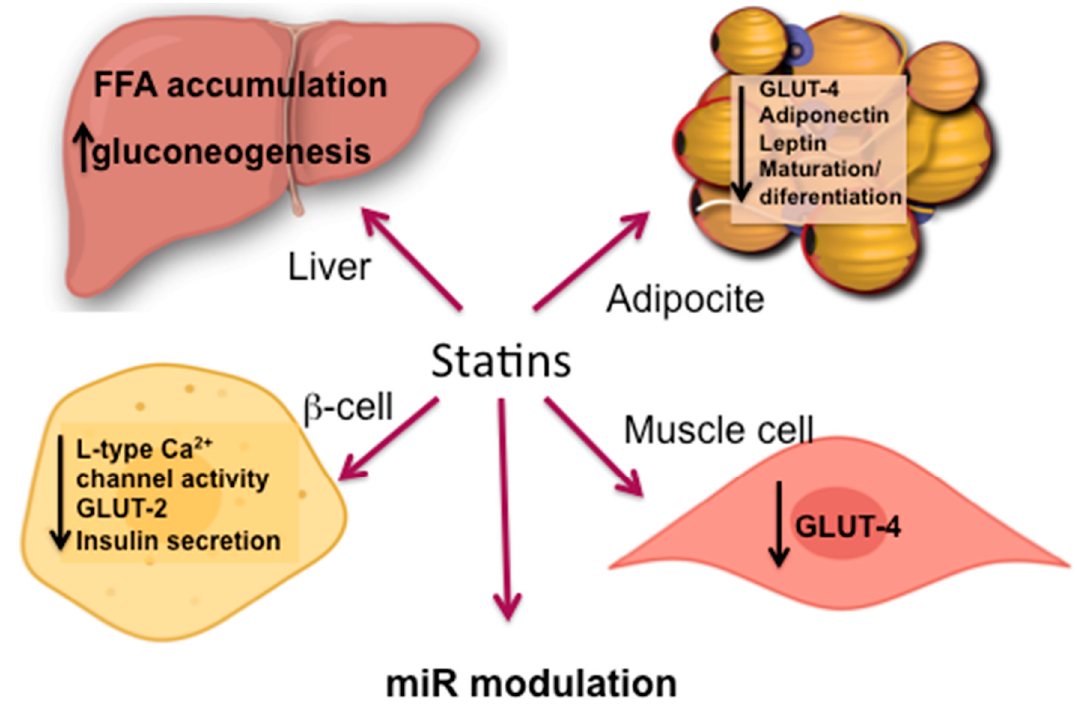
Figure 2. Principal mechanisms for T2DM development induced by statins.